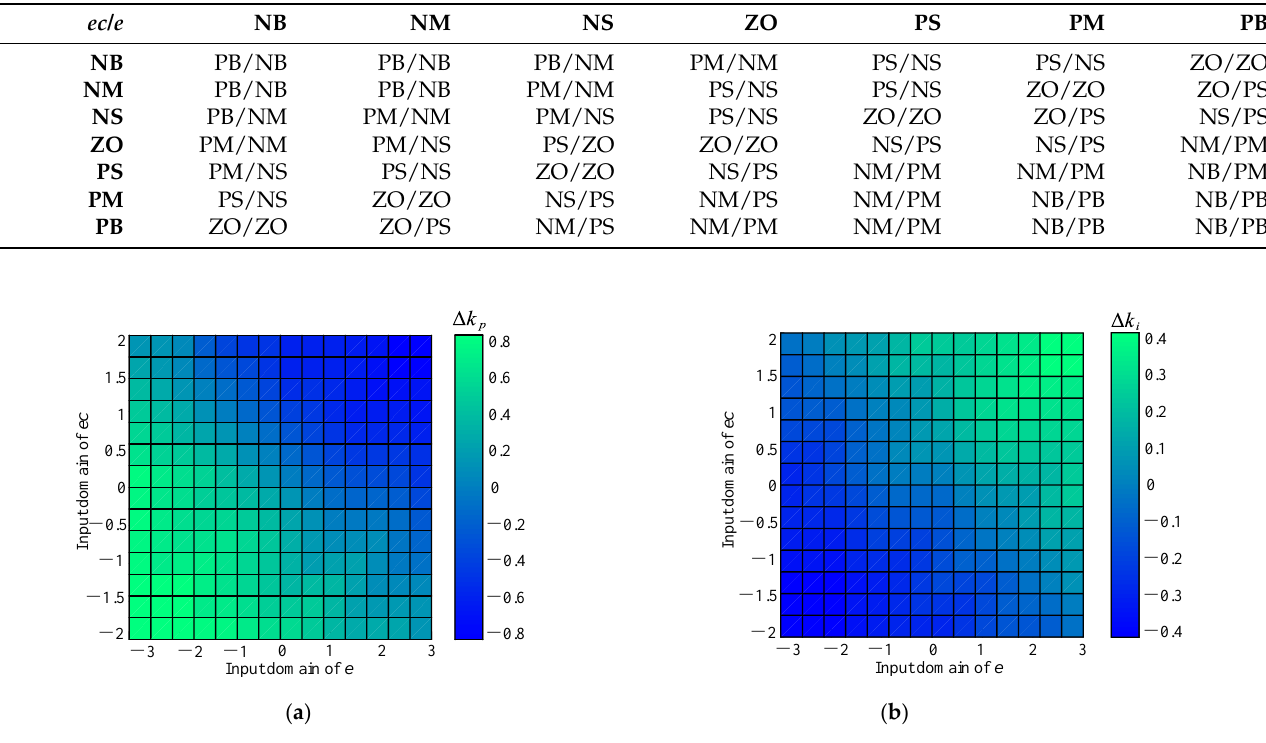
Figure 4. ∆𝑘 𝑝 and ∆𝑘 𝑖 fuzzy rule inference diagram. Figure 4. ( a ) ∆ k p and ( b ) ∆ k i fuzzy rule inference